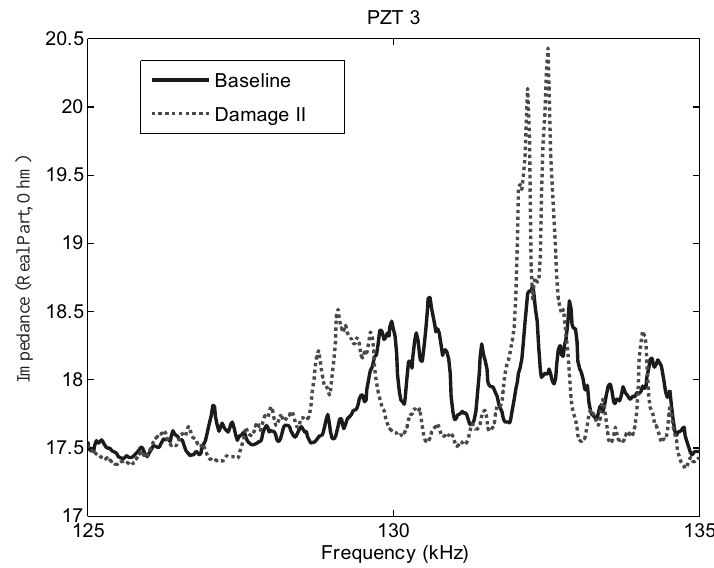
Fig. 5. Electrical Impedance measurement from PZT 3 before and after Damage